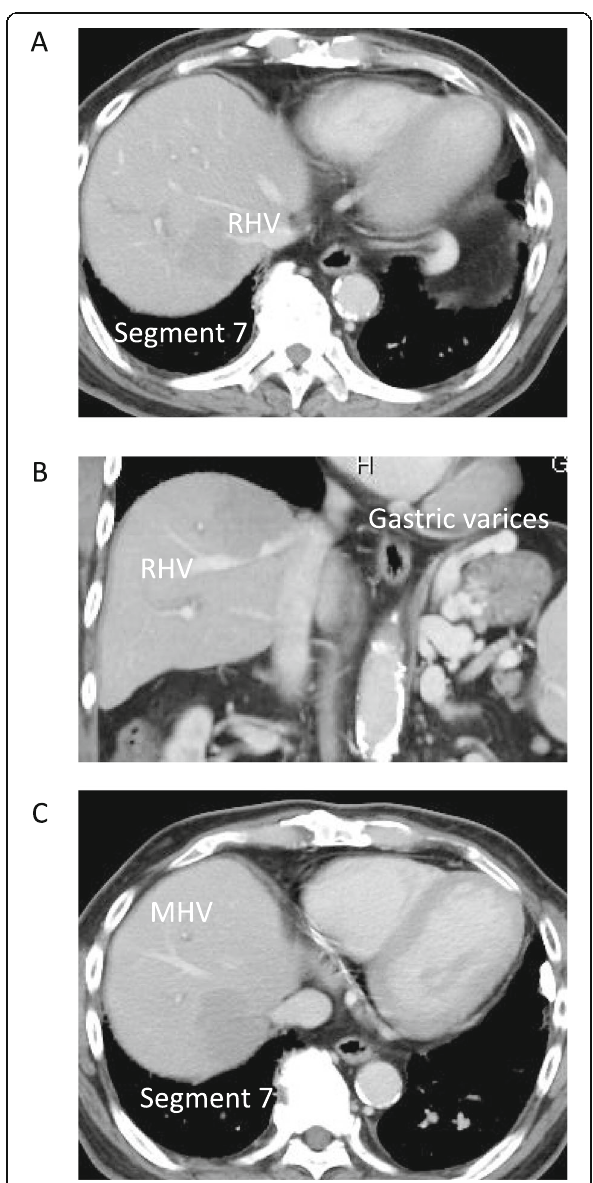
Fig. 1 CT imaging of HCC. CT showing the tumor located in segment 7 involving the right hepatic vein, a transverse plane, b coronal plane, and c close to the middle hepatic vein.